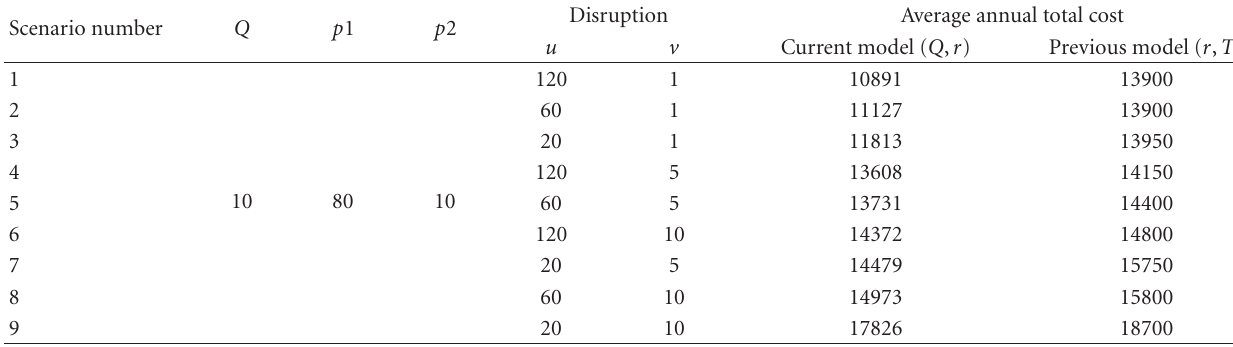
Table 4: Compare current model with previous study under di ff erent scenarios of v and u .